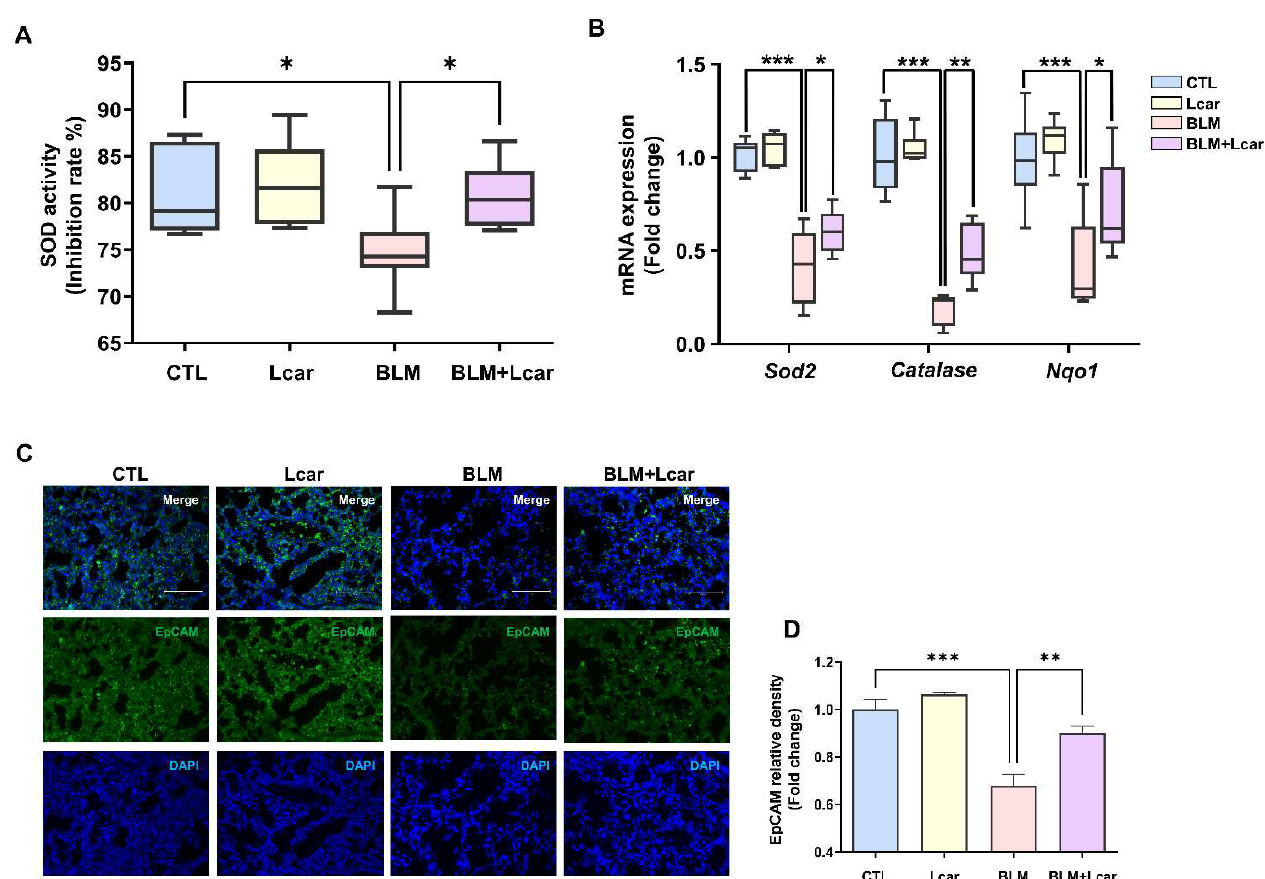
Figure 4. L-carnosine improved ROS-induced anti-oxidant activity. ( A ) SOD activity was measured by the SOD determination kit ( n = 4/group). ( B ) mRNA expression of antioxidant-related genes was measured by real-time PCR ( n = 4/group). ( C ) Representative images of immunofluorescence staining of lung tissues using EpCAM antibody. ( D ) Relative density expression graph as fold change relative to control group ( n = 4/group). A value of * p < 0.05, ** p < 0.01, and *** p < 0.001 was compared with each indicated group by one-way ANOVA. CTL, Control; L-car, L-carnosine; BLM, Bleomycin; Scale bar: 30 μm.